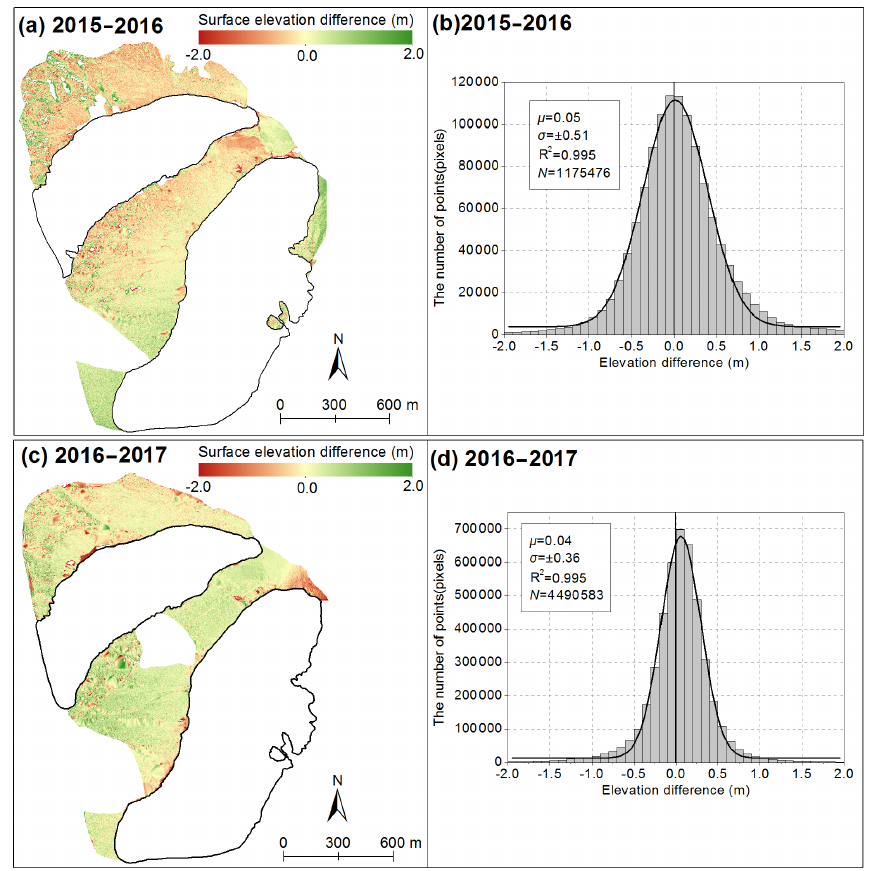
Figure 3. Statistics on annual surface elevation changes over stable terrain extracted by differencing of TLS-derived DEMs from 2 consecu- tive years. Spatial and corresponding frequency distributions of these changes for mass-balance year 2015–2016 (a, b) and 2016–2017 (c, d) . The median ( µ ) and the standard deviation ( σ ) of the elevation differences as well as the number of pixels ( N ) over stable terrain are